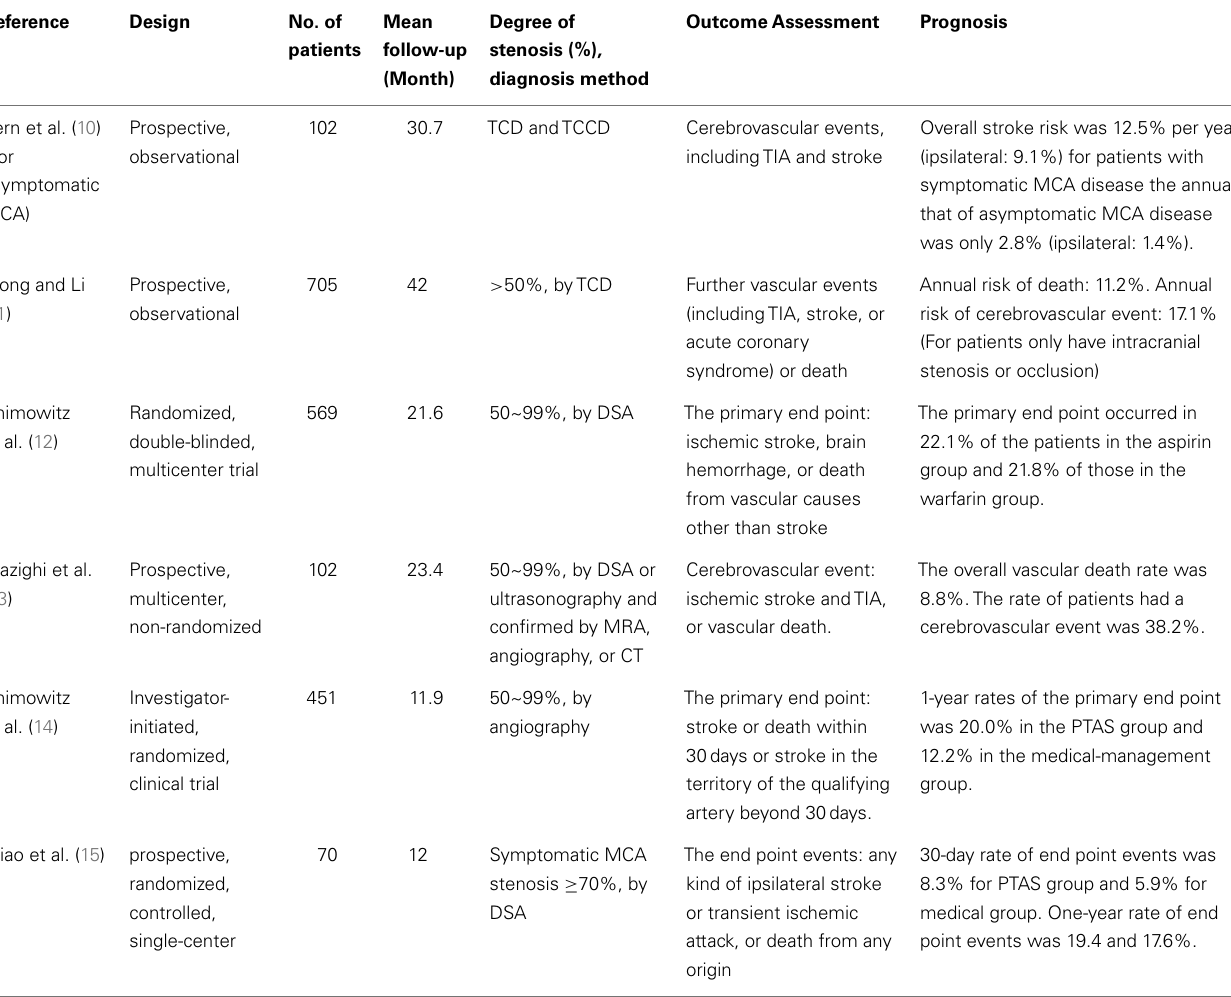
Table 1 | Major trials investigating prognosis of asymptomatic and symptomatic intracranial large artery stenosis or occlusion disease